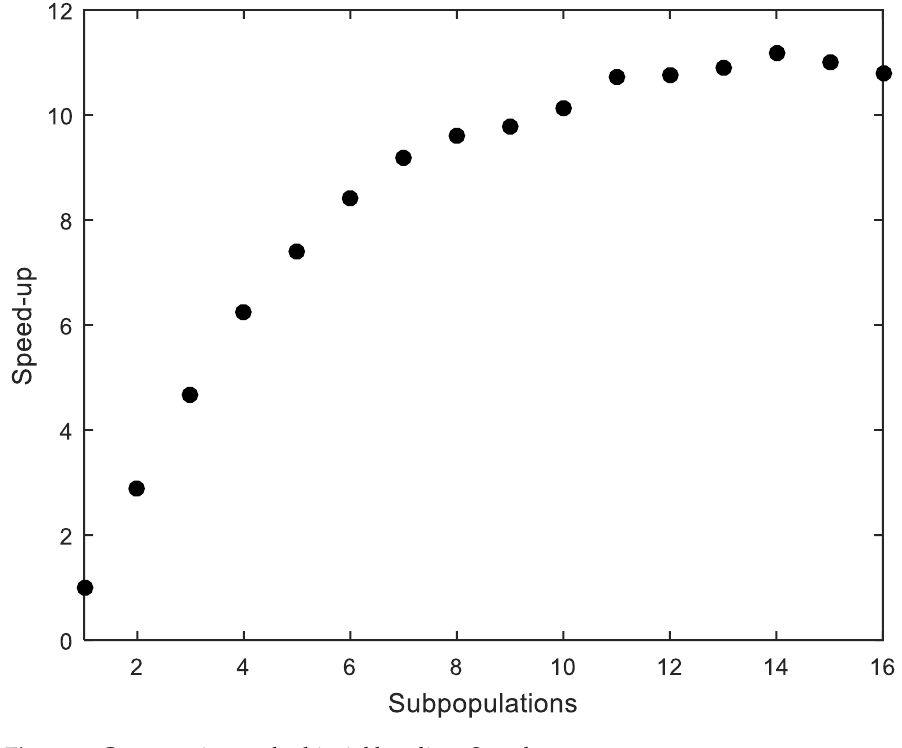
Figure 8. Cross-section under biaxial bending. Speed-up.